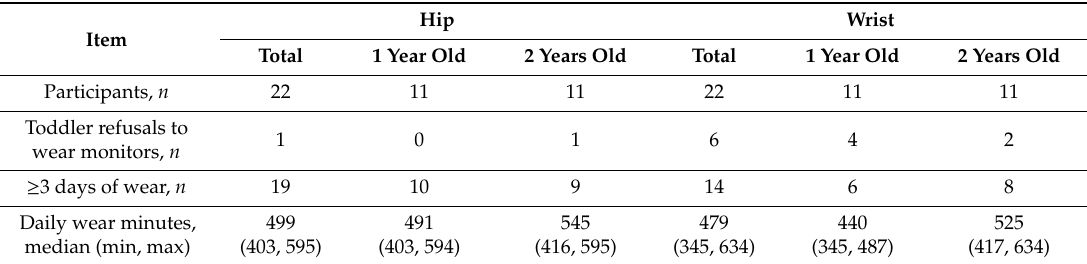
Table 1. Compliance with the accelerometer monitoring protocol among toddlers.